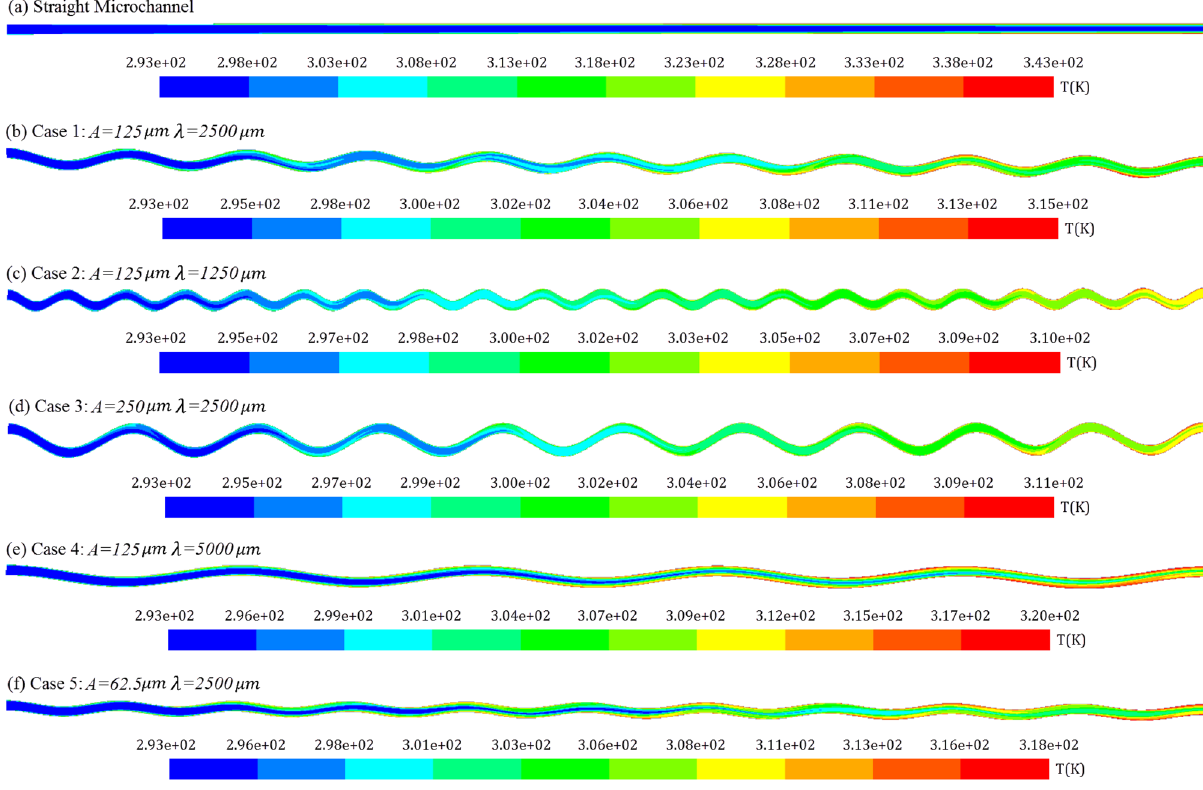
Figure 8. Temperature contours along the microchannel length for: ( a ) Straight channel, ( b ) Case 1 (A = 125 μm, λ = 2500 μm), ( c ) Case 2 (A = 125 μm, λ = 1250 μm), ( d ) Case 3 (A = 250 μm, λ = 2500 μm), ( e ) Case 4 (A = 125 μm, λ = 5000 μm), and ( f ) Case 5 (A = 62.5 μm, λ = 2500